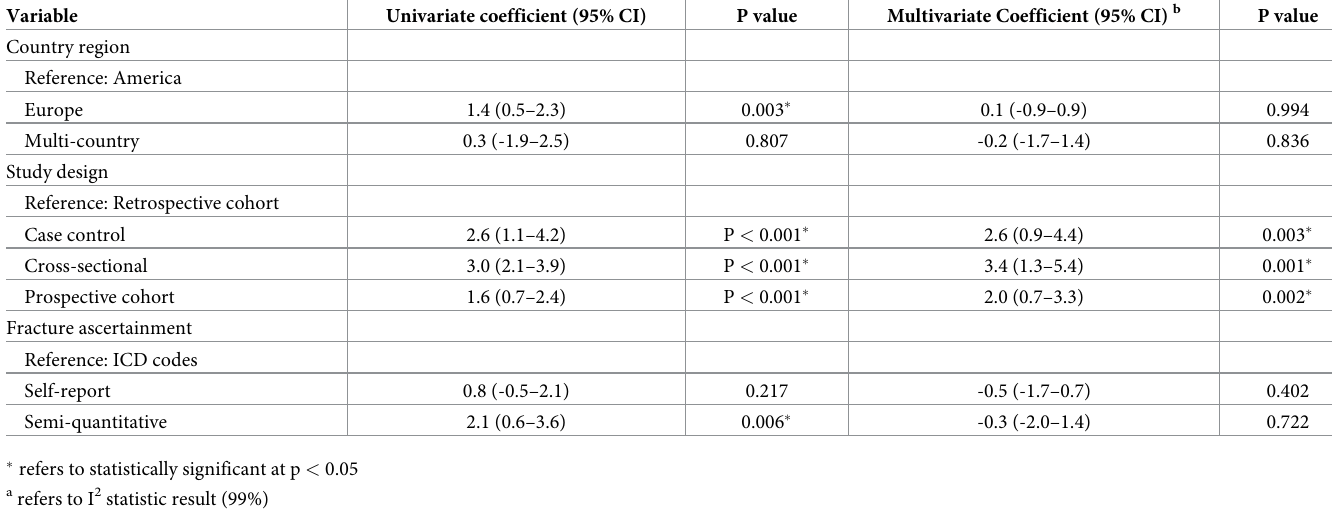
Table 5. Meta-regression analysis of fracture risk factors affecting heterogeneity on prevalence a